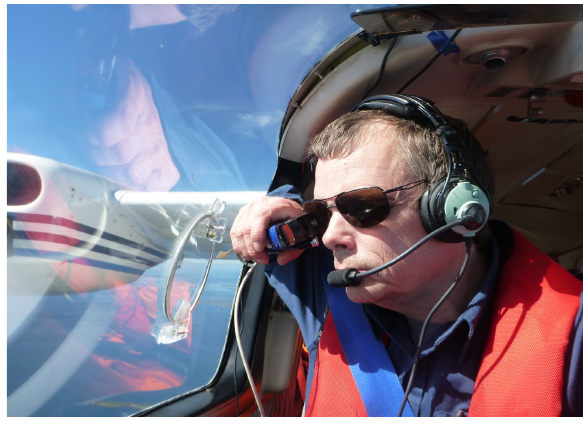
Figure 6. Wake up! (Photo: D. G.